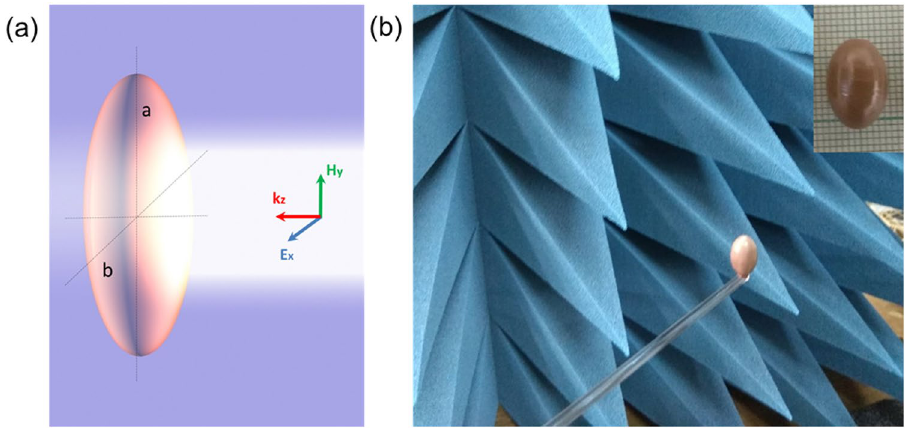
Figure 1. ( a ) Illustration of high-index dielectric prolate spheroidal particle with dielectric permittivity ε =150 and the major and minor semiaxes of a and b , respectively. Linearly polarized plane wave is impinging laterally with vector E parallel to minor axis. ( b ) Experimental sample of ceramic spheroidal particle with a = 19.5/2 mm and b = 12.5/2 mm in anechoic chamber. The inset shows picture of sample.